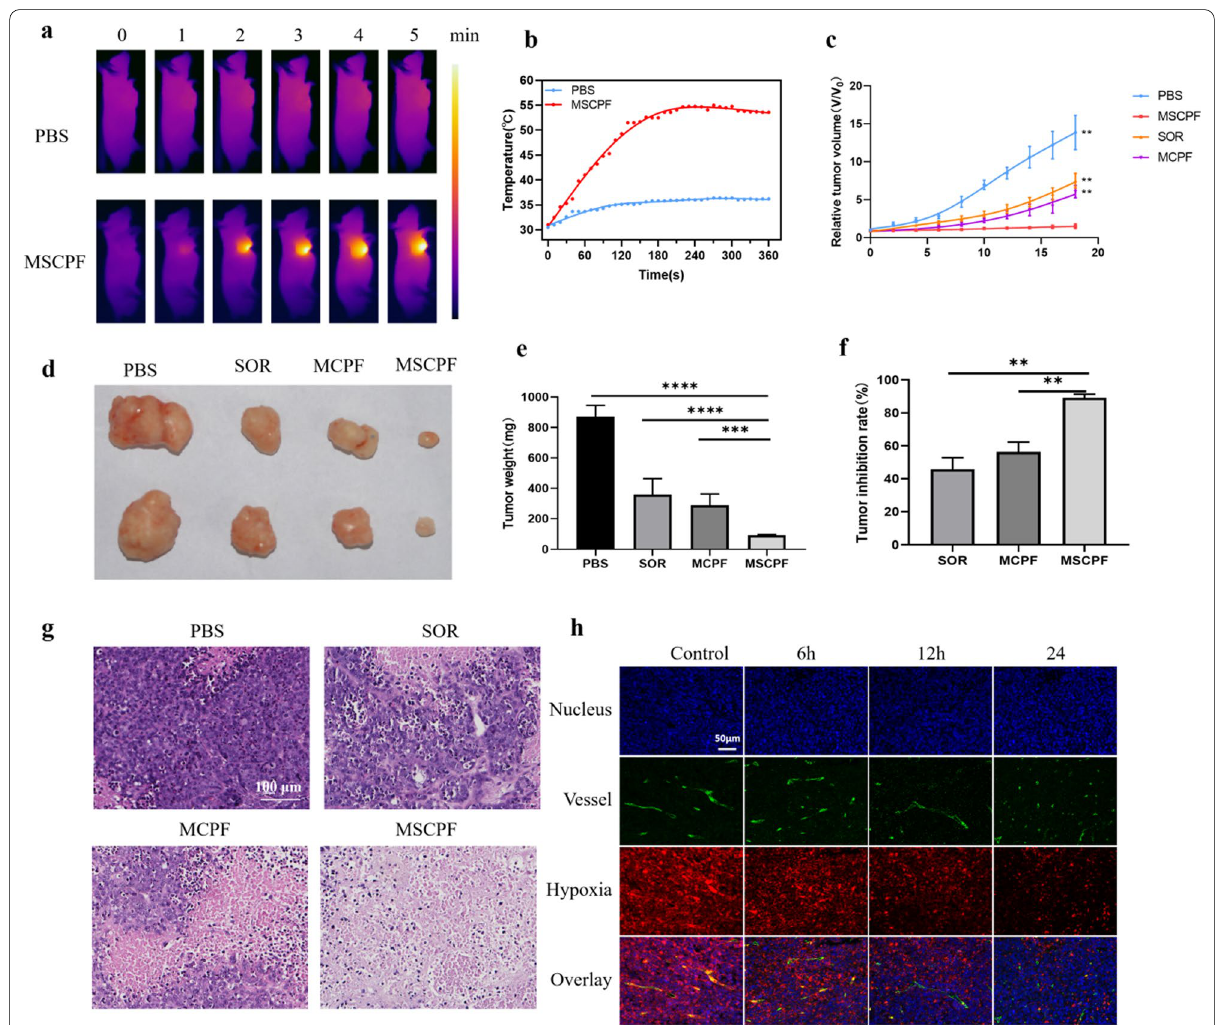
Fig. 7 In vivo anti-tumor effect of MSCPF NPs. a IR thermal imaging by exposing tumors of mice to irradiation of 808 nm at 1.5 W cm − 2 for 10 min after injection of PBS or MSCPF. b The temperature increase curve of tumors in the PBS and MSCPF groups after exposure to 808 nm irradiation. c Tumor growth curves of the mice during the experiment. d Photographs of the tumors harvested from mice at the end of treatment. e The weight of the tumors was measured. f The tumor inhibition rate of PBS, SOR, MCPF, or MSCPF on mice bearing SMMC-7721 tumors. g Representative HE staining histological sections of mouse tumors. h Immunofluorescence images of tumor slices of mice in control and the MSCPF-treated group after 6, 12, and 24 h injection. The nucleus, vessels, and hypoxic areas were respectively stained with 4 ′ ,6-diamidino-2-phenylindole (DAPI) (blue), anti-CD31 antibody (green), and anti-pimonidazole antibody